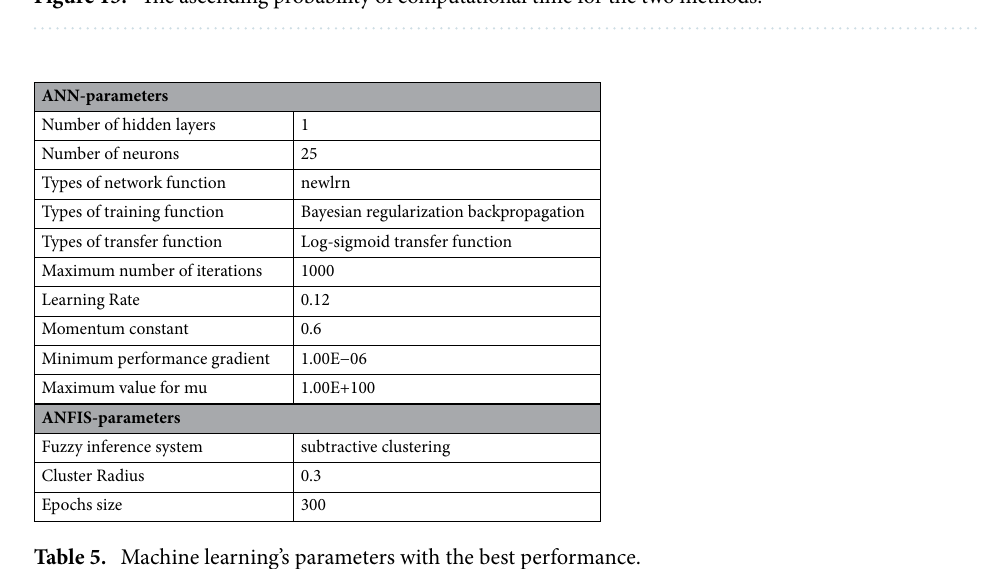
Figure 13. The ascending probability of computational time for the two methods.